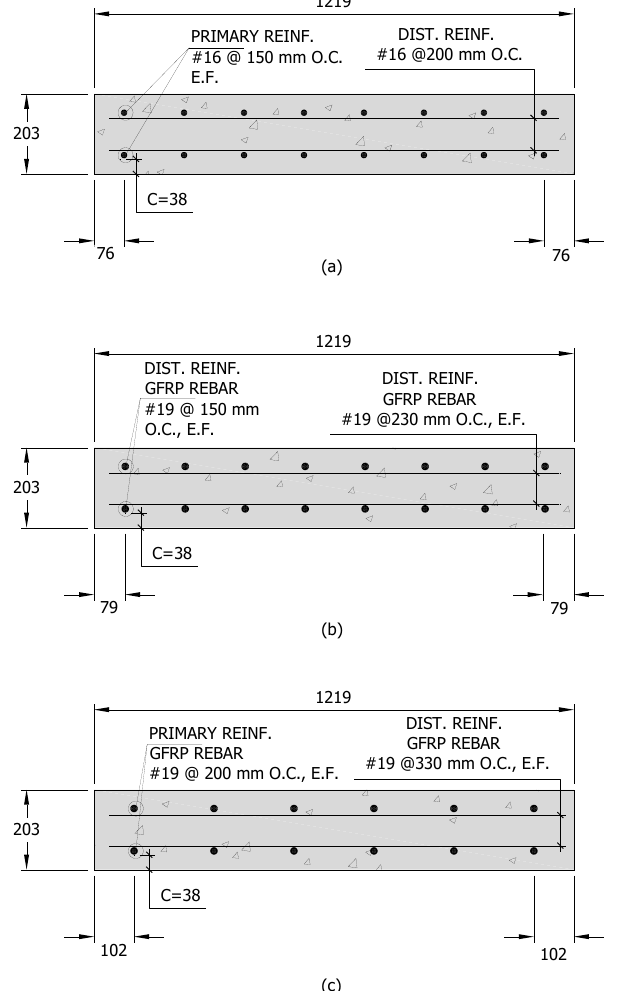
Figure 2. Deck reinforcement layout for ( a ) Steel-Reinforced Decks, ( b ) GFRP-Reinforced Decks, and ( c ) Hybrid Decks.